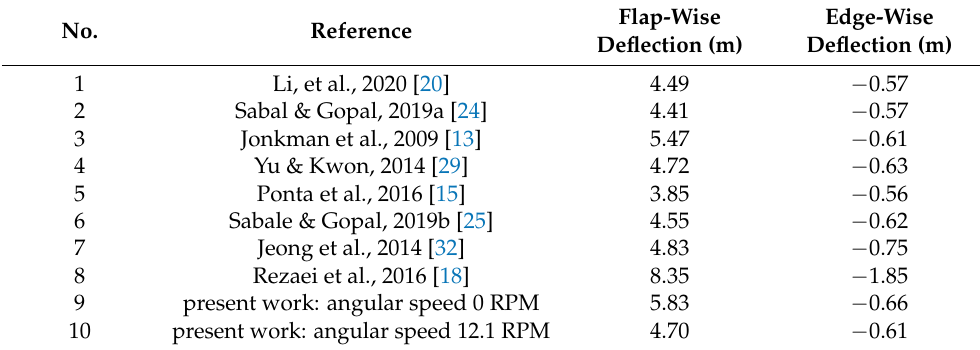
Table 5. Comparison of the dynamic response under nominal working conditions, in the present work, the modal parameters were calculated for angular speeds of 0 RPM and 12.1 RPM, while in all the reference results, the modal parameters were calculated for zero angular